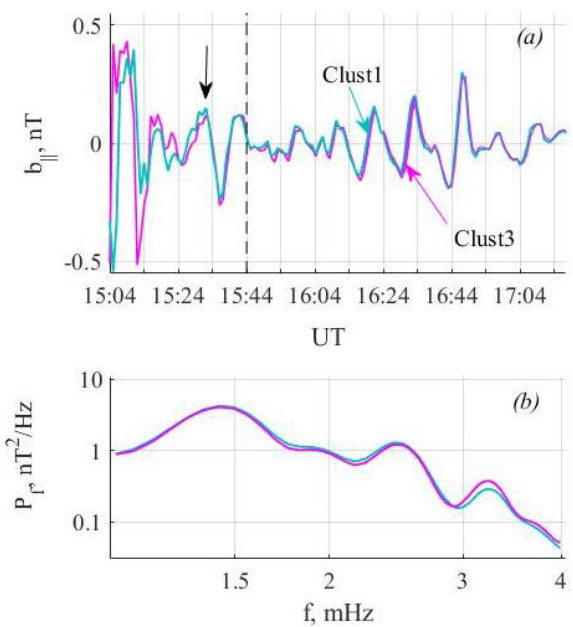
Figure 7. (a) Pulsations of the b || component in the magnetotail, recorded by Cluster 1 and 3 during the interval starting at 15:04UT. (b) PSD spectra for the 96min interval starting at 15:44UT (the start instant of the window for which the spectra are calculated is marked with a vertical dashed line). The change in pulsation regime is marked using an arrow. Pulsations at Cluster 1 and 3 are shown using the same colours in all panels.